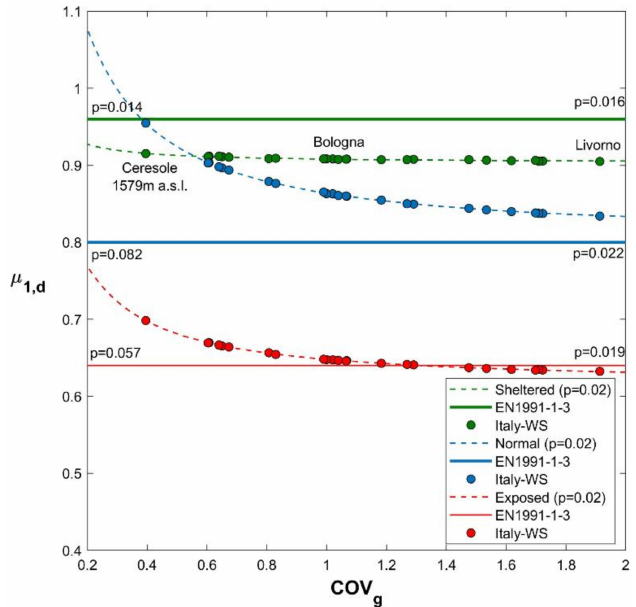
Figure 4. Design shape coefficient for flat roofs ( µ 1, d ) as a function of the coefficient of variation ( COV g ) of ground snow load, parameterized in terms of exposure conditions (sheltered: green lines, normal: blue lines, exposed: red lines) for 25 Italian weather